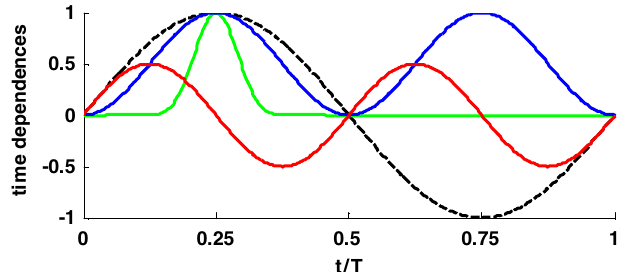
FIG. 10. (Color) Time dependences of electric field (dashed black line), active power flow (blue), reactive power flow (red), and field emission power flow (green) are shown.